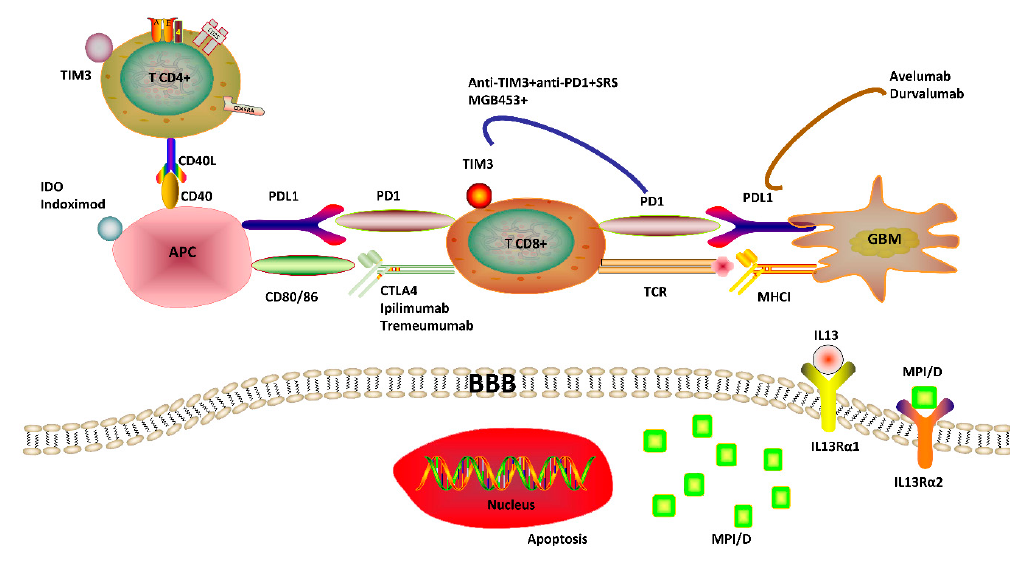
Figure 3. Immunotherapy with Controlled Nano-drug Delivery System for Glioblastoma. ( 1 ) Doxorubicin (DOX)-loaded mesoporous silica nanoparticle (MSN) coated with IL13R α 2-targeted